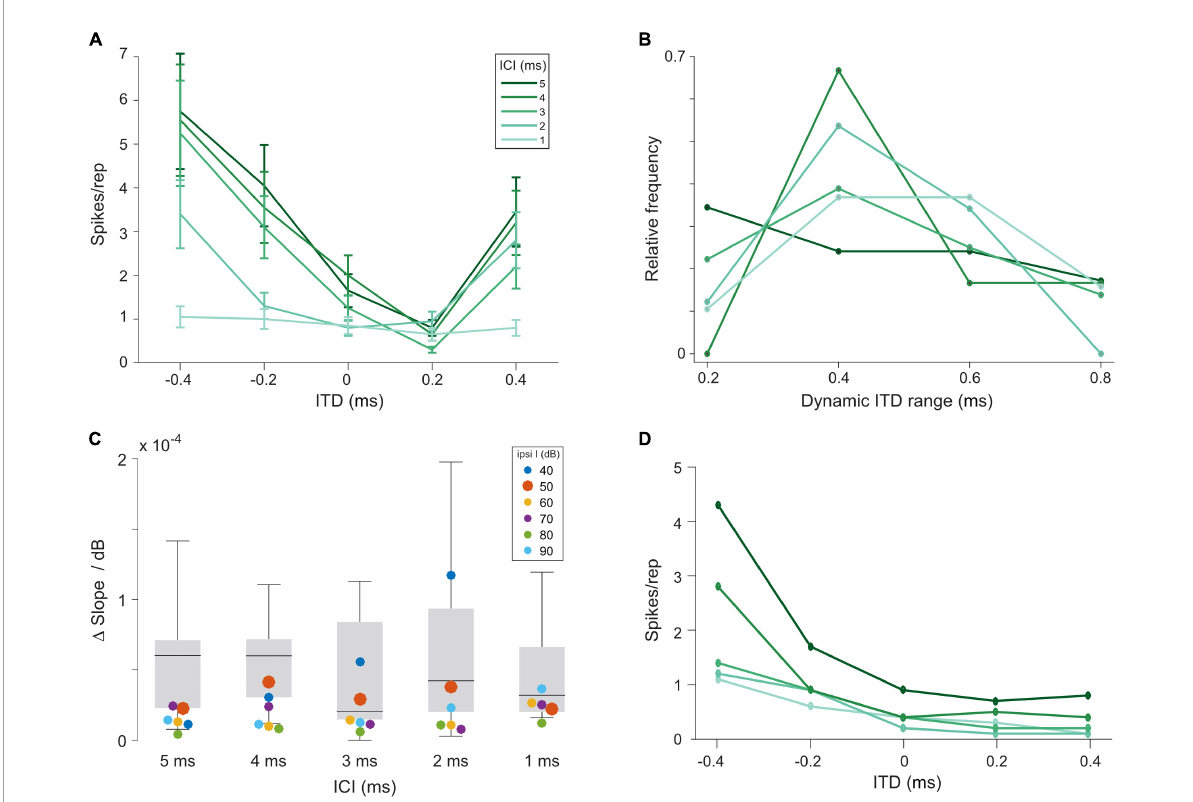
FIGURE3 Interaural time differences (ITD) sensitivity of lateral superior olive (LSO) neurons to click trains is maintained over a large range of interaural level differences (ILDs). (A) Example rate-ITD function from a gerbil LSO neuron. Plotted are mean rates and the standard errors. (B) Histogram of dynamic ITD ranges at ILD = 0 dB across all 15 recorded LSO neurons. (C) Quantification of magnitude of changes in the slope steepness of rate-ITD functions with changes in ILD for gerbil LSO (boxplots) and model (at various intensities of the excitatory input, colored dots). The δ slope/dB was calculated by first determining the slope of rate-ITD functions (difference in the normalized maximal and minimal spike rates divided by the respective ITD range), and then subtracting these values between the most positive and negative ILD that each LSO neuron was tested for and dividing this difference by the respective difference in ILD. (D) Model rate-ITD function during acoustic stimulation (ipsi intensity = 50 dB; ILD = 0 dB).